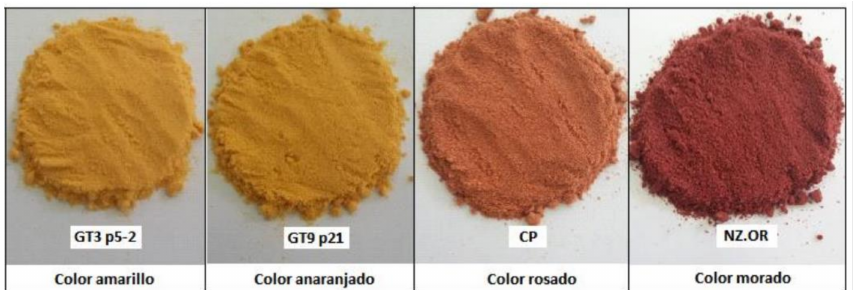
Figure 3. Different pulp fruit colors obtained from tree tomato samples of the breeding